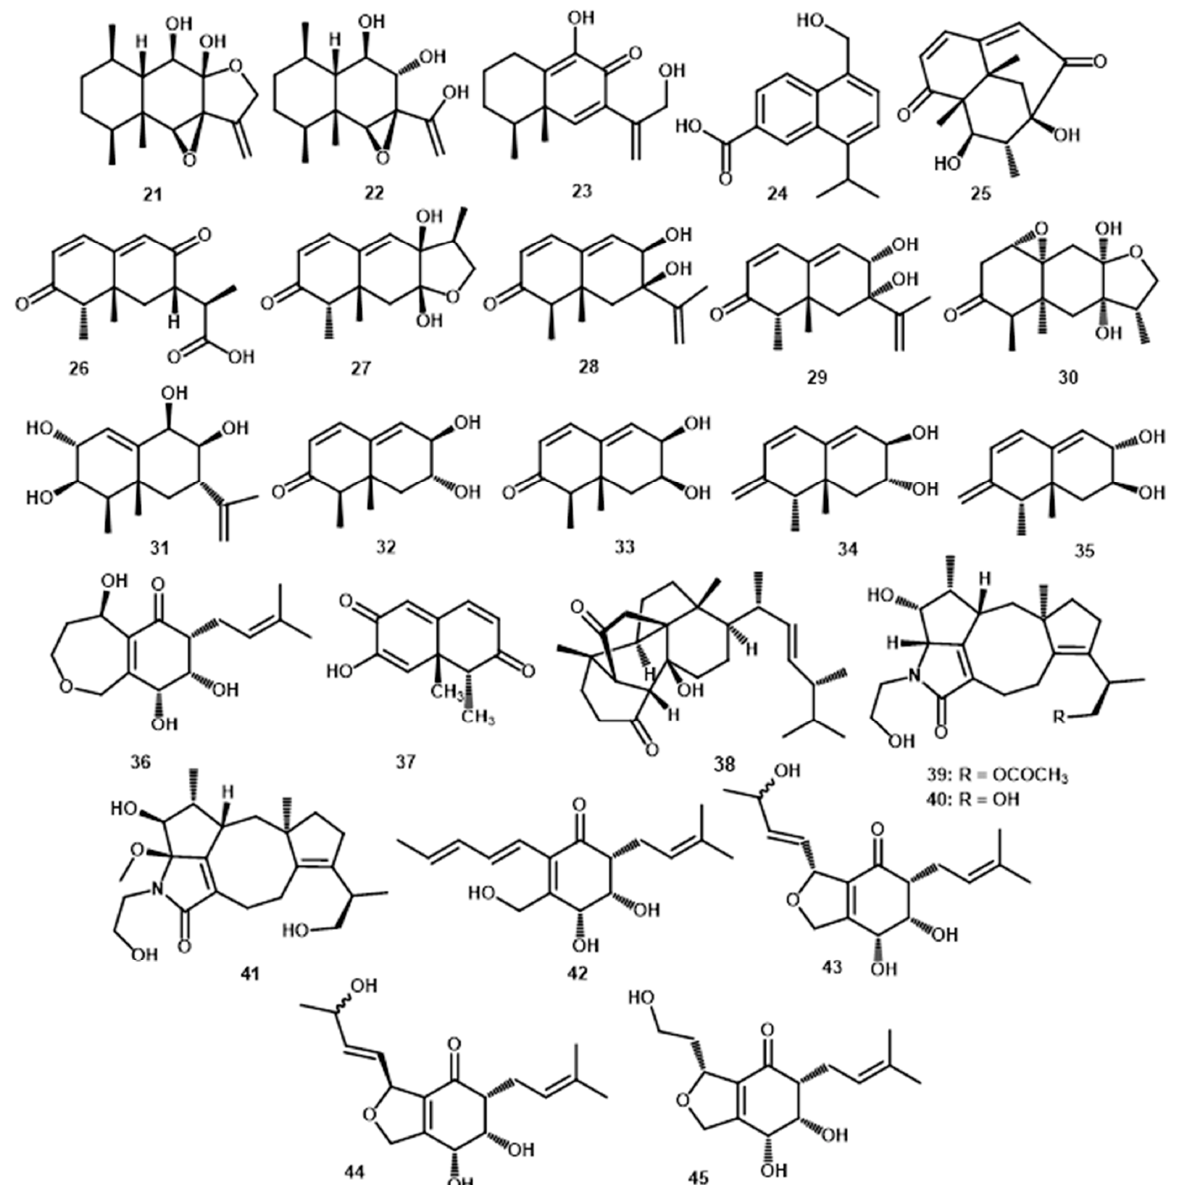
Figure 3. The chemical structures of terpenoids 21 – 45 from the Periconia genus.